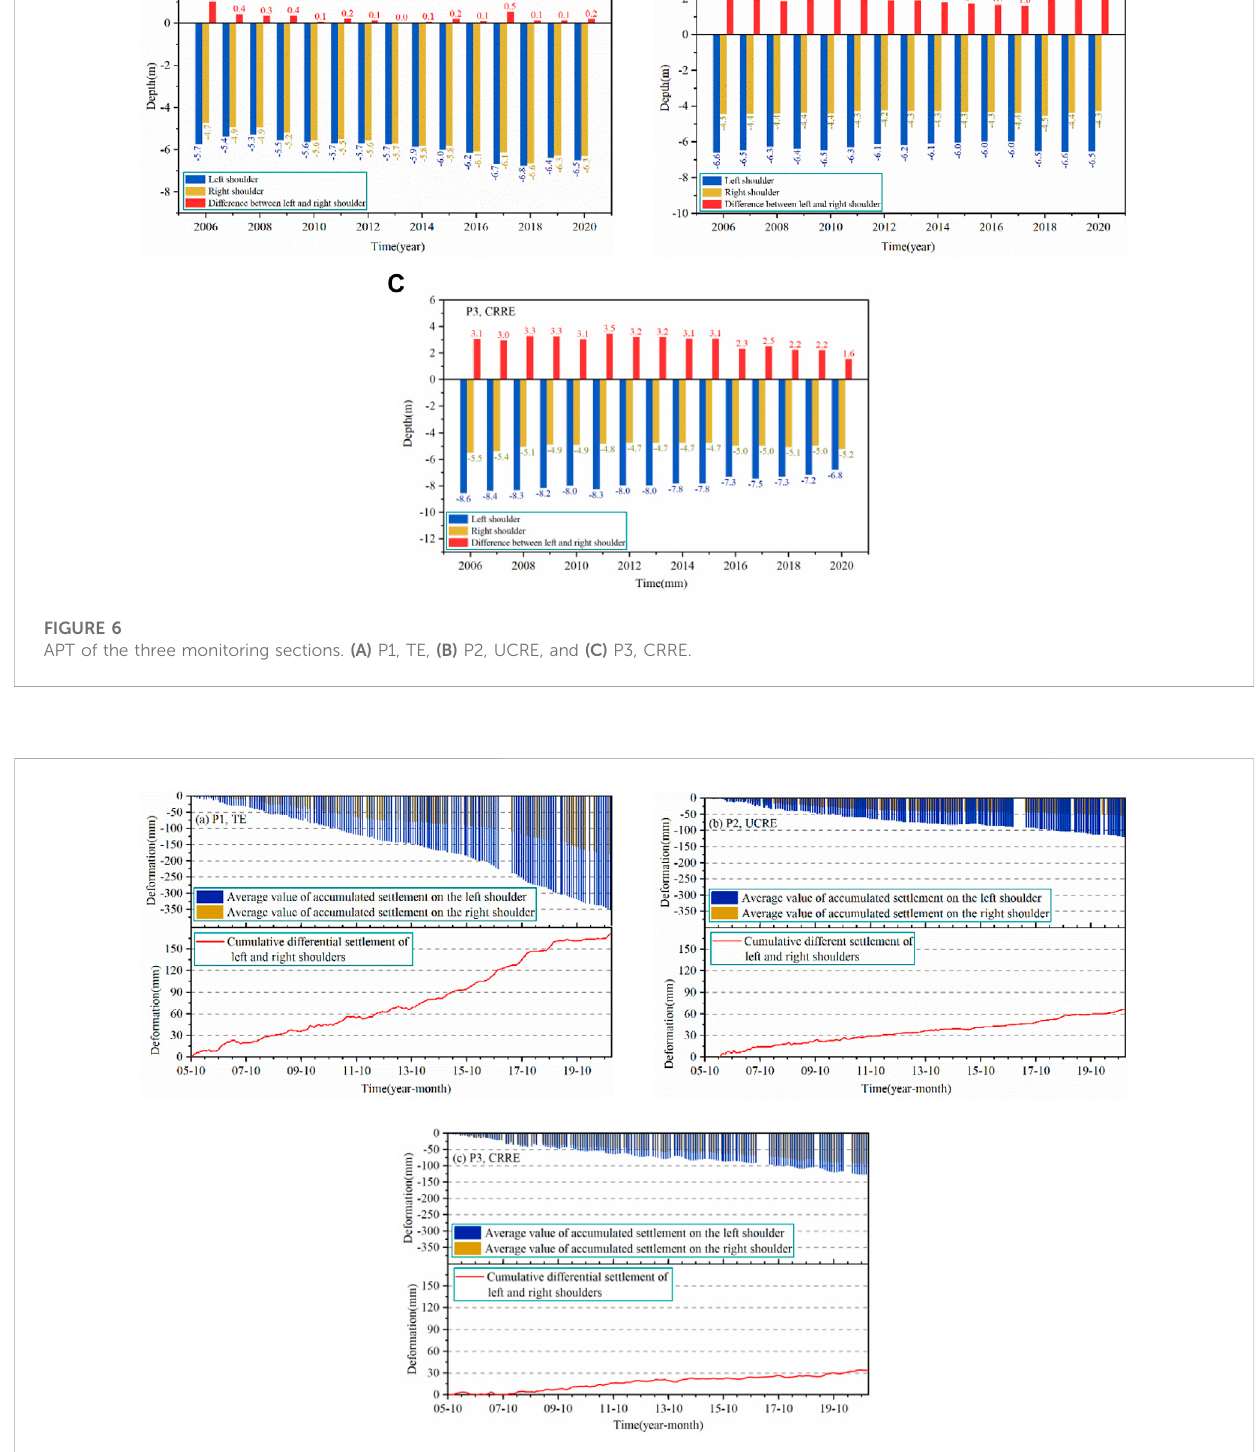
Differential settlementtrendoftheleftandrightembankment shouldersinthethreemonitoringsections. (A) P1,TE, (B) P2,UCRE,and (C)